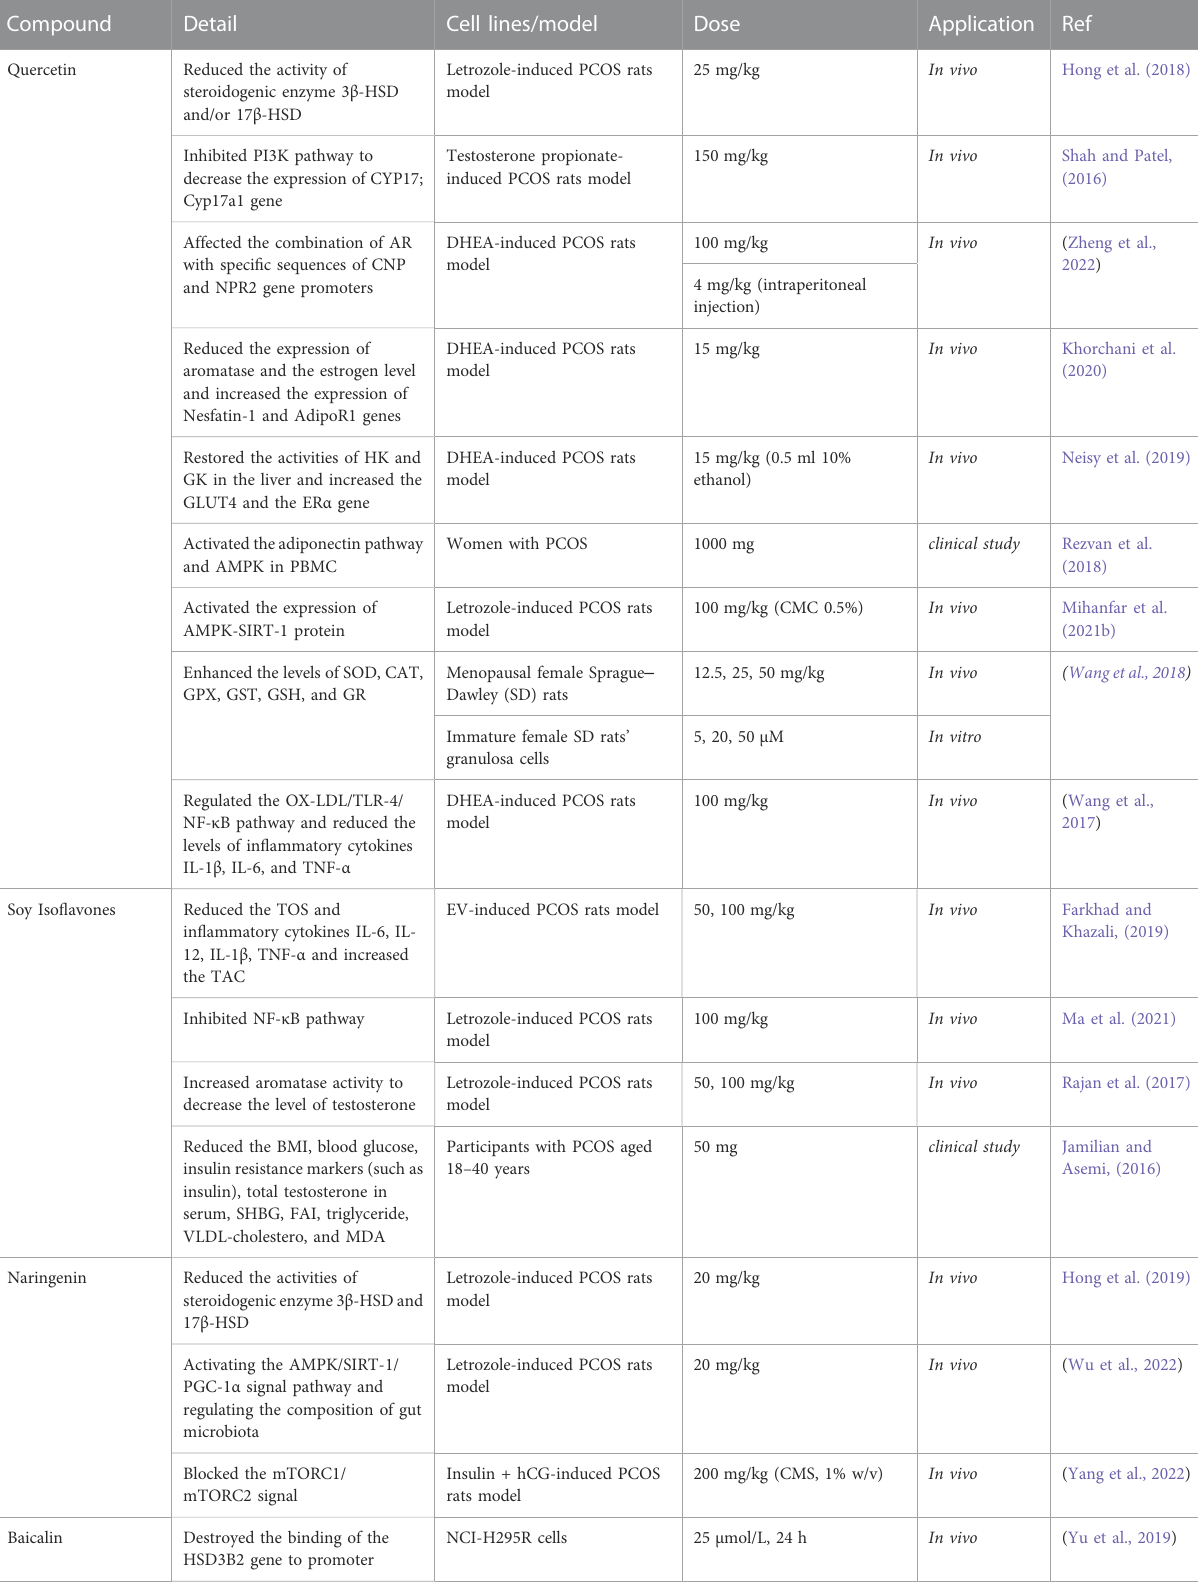
TABLE 1 Therapeutic effects of fl avonoids on